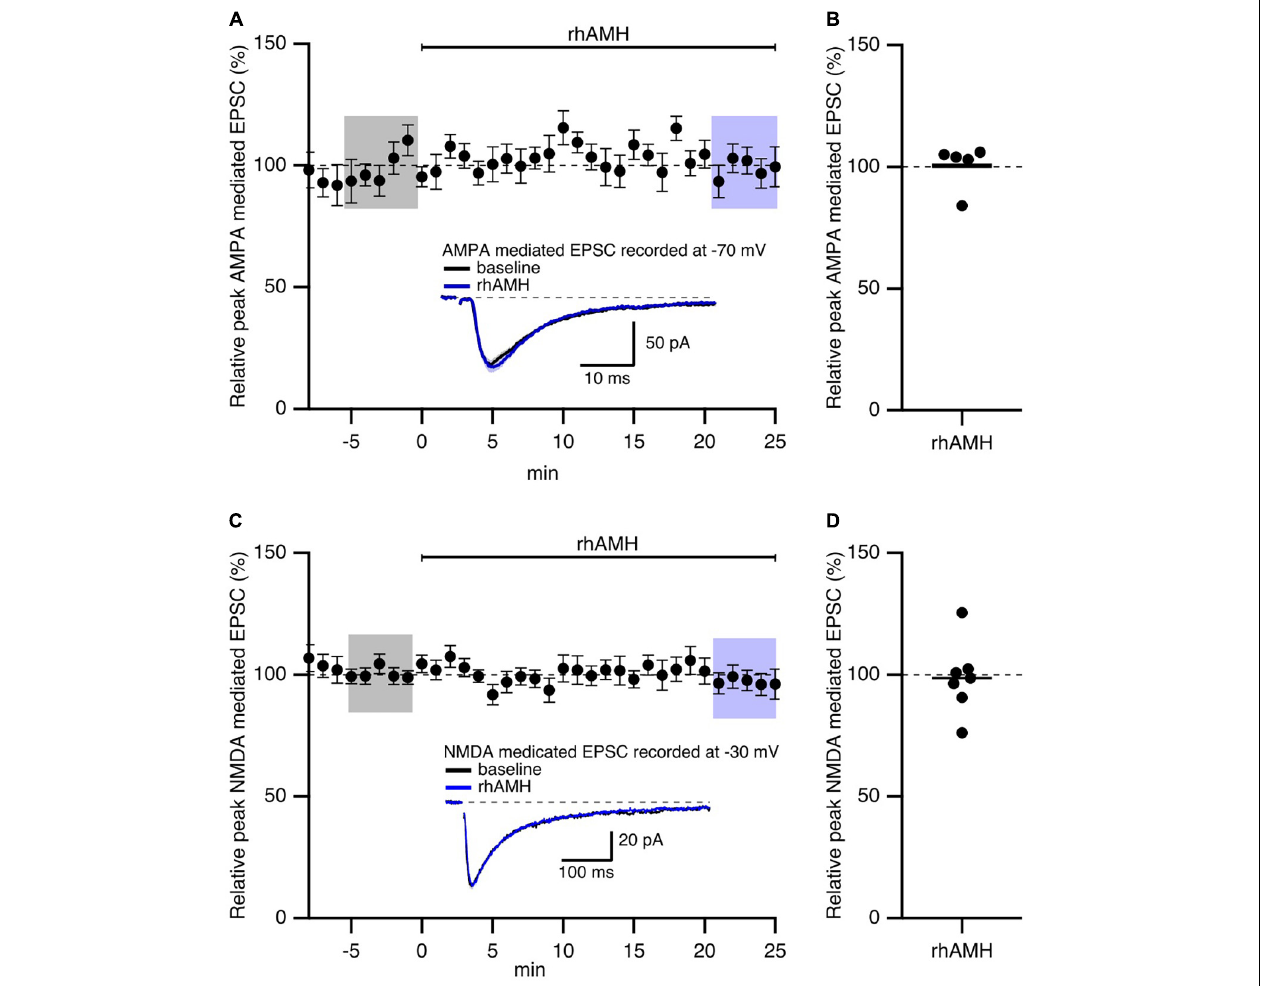
FIGURE 3 | Anti-Müllerian hormone does not affect AMPAR- or NMDAR-mediated EPSCs in mouse hippocampus. Summary time course plots of normalized EPSC amplitudes of hippocampal slices with bath application of 0.4 nM recombinant human AMH protein (rhAMH) at 0–25 min. rhAMH addition did not increase AMPAR-mediated EPSC in the presence of 50 µ M D-AP5 (A) or NMDAR-mediated EPSC in the presence of 25 µ M CNQX (C) . Data are binned into 1 min intervalsm mean ± SEM. The current traces used for averaging were taken at time points highlighted with gray and blue shadings. Representative current traces (average of 15 EPSCs) were acquired in the control solution (baseline, black) and in the presence of rhAMH (blue) for individual neurons. (B,D) Summary scatterplots of normalized EPSC amplitude.